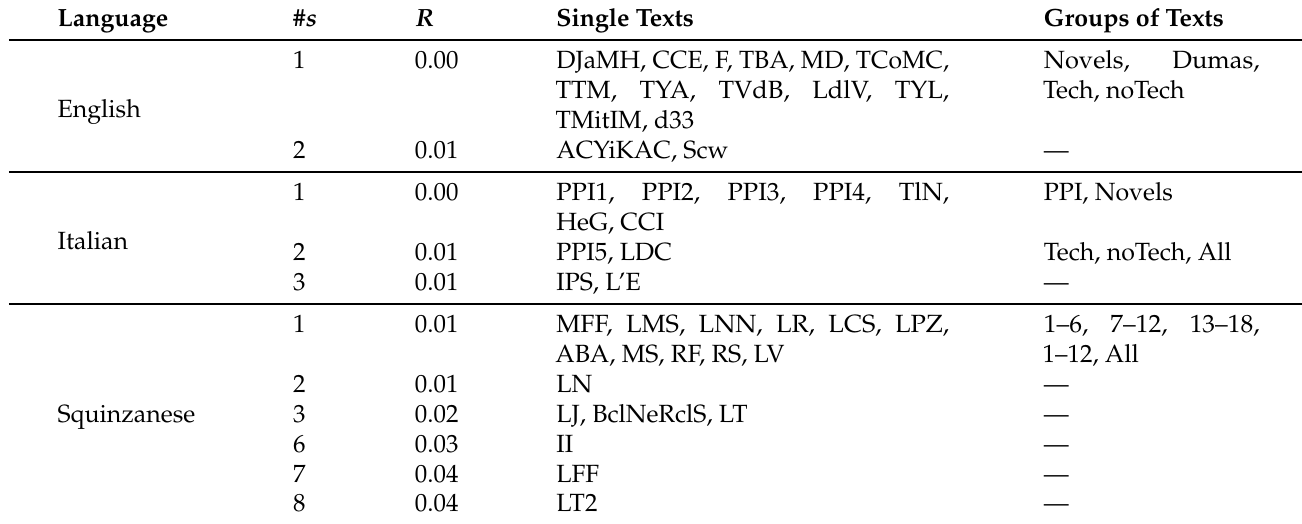
Table 10. Performance of baseline cutoff